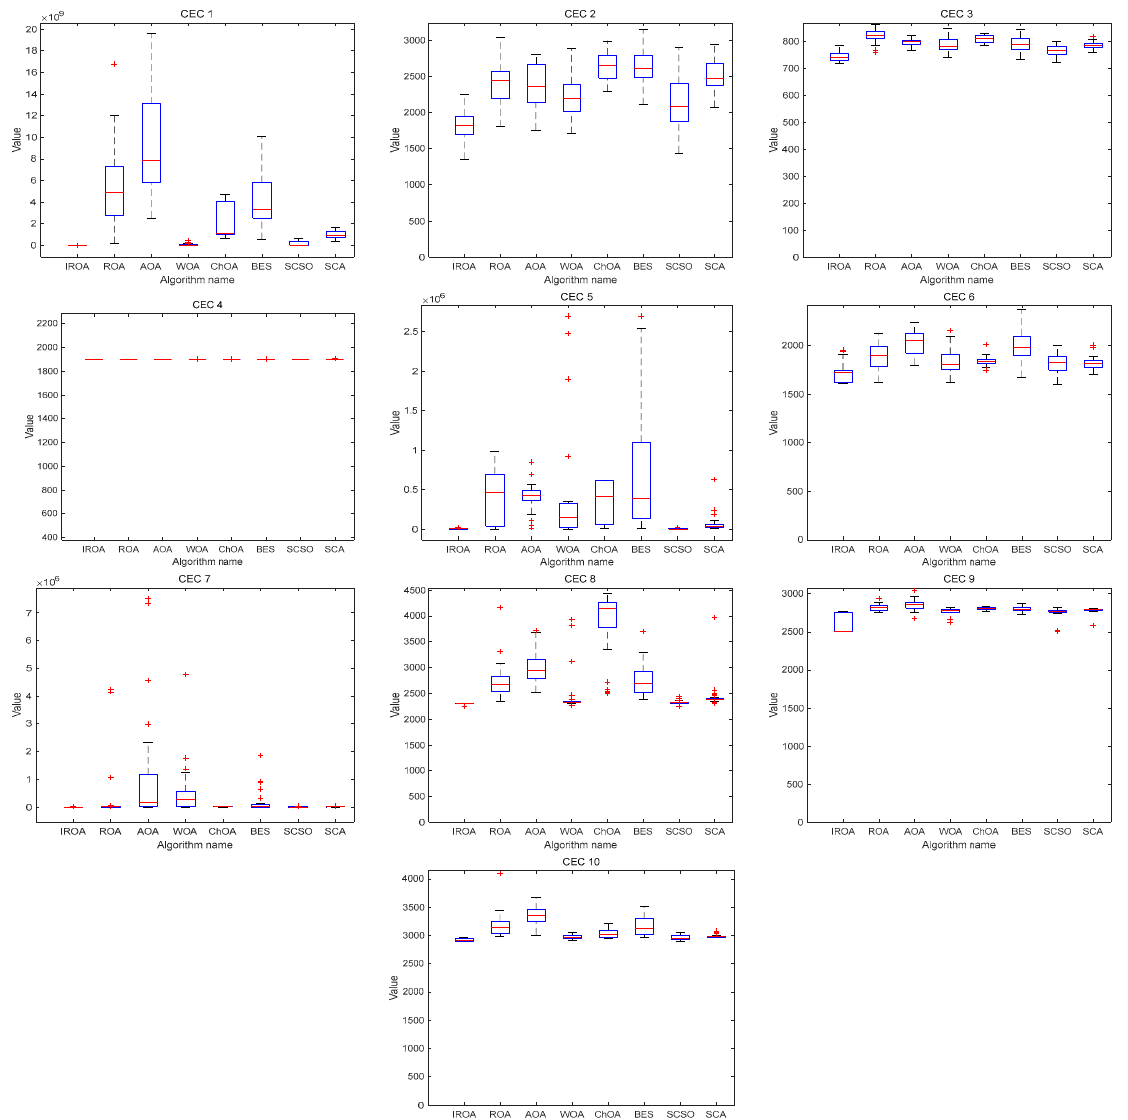
Figure 8. Box diagram of eight algorithms in CEC2020 benchmark function.